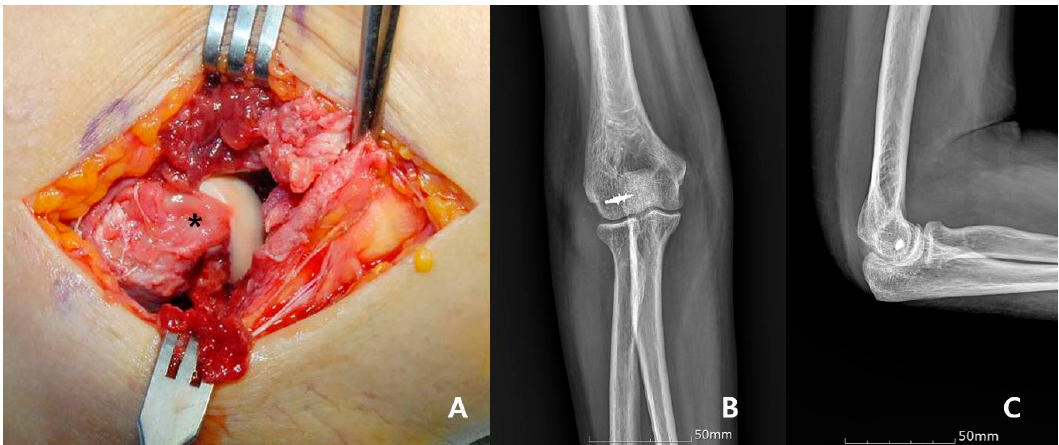
Figure 3. A 59-year old woman treated by repair of LCL alone. Intraoperative photograph reveals that the LCL and common extensor complex had a distractive tear pattern and were retracted from the lateral epicondyle (asterisk) ( A ). The lateral collateral ligament and common extensor complex are repaired with suture anchors; postoperative anteroposterior ( B ), and lateral ( C ) radiograph.